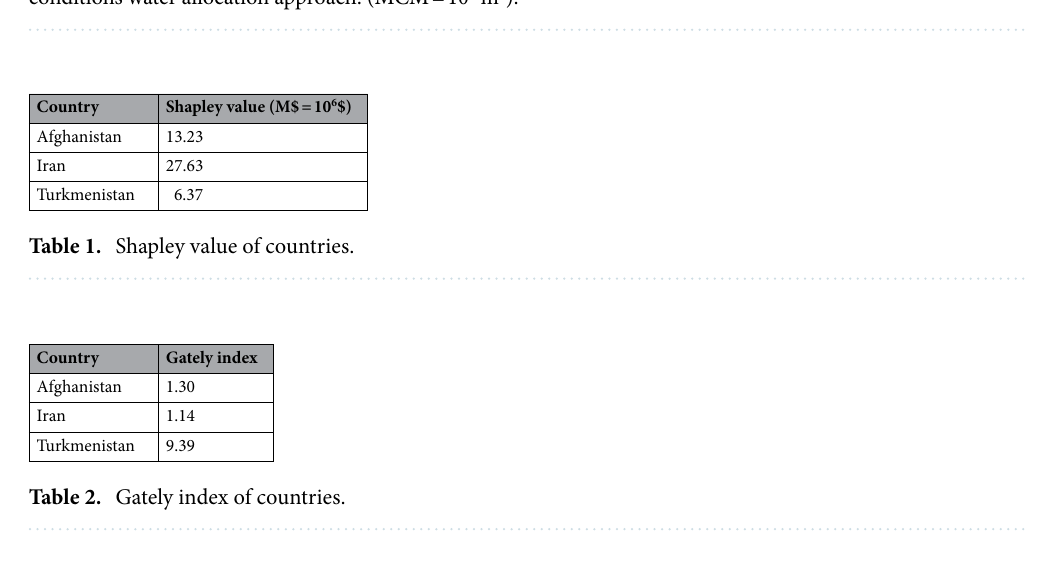
Figure 3. The average annual volume of water supply and demand for each country calculated with the initial- conditions water allocation approach. (MCM = 10 6 m 3 ).